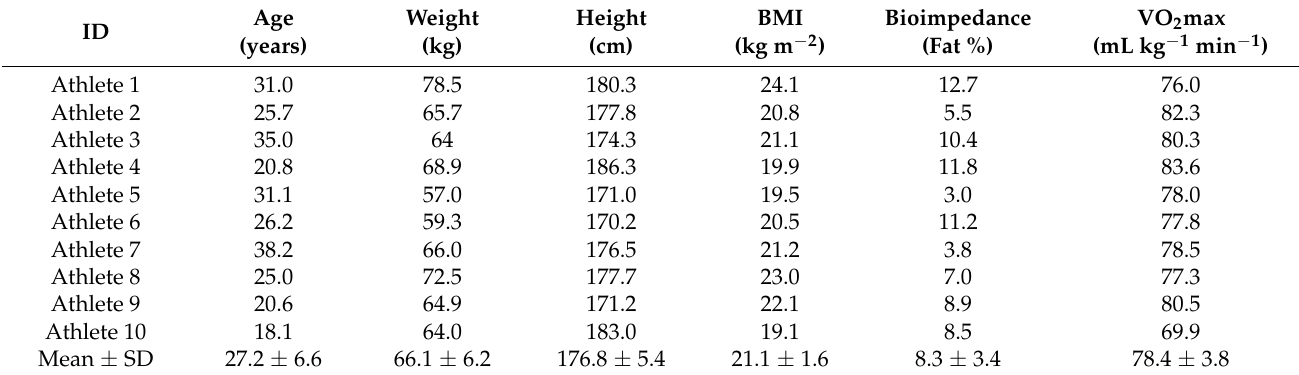
Table 1. Descriptive characteristics of the